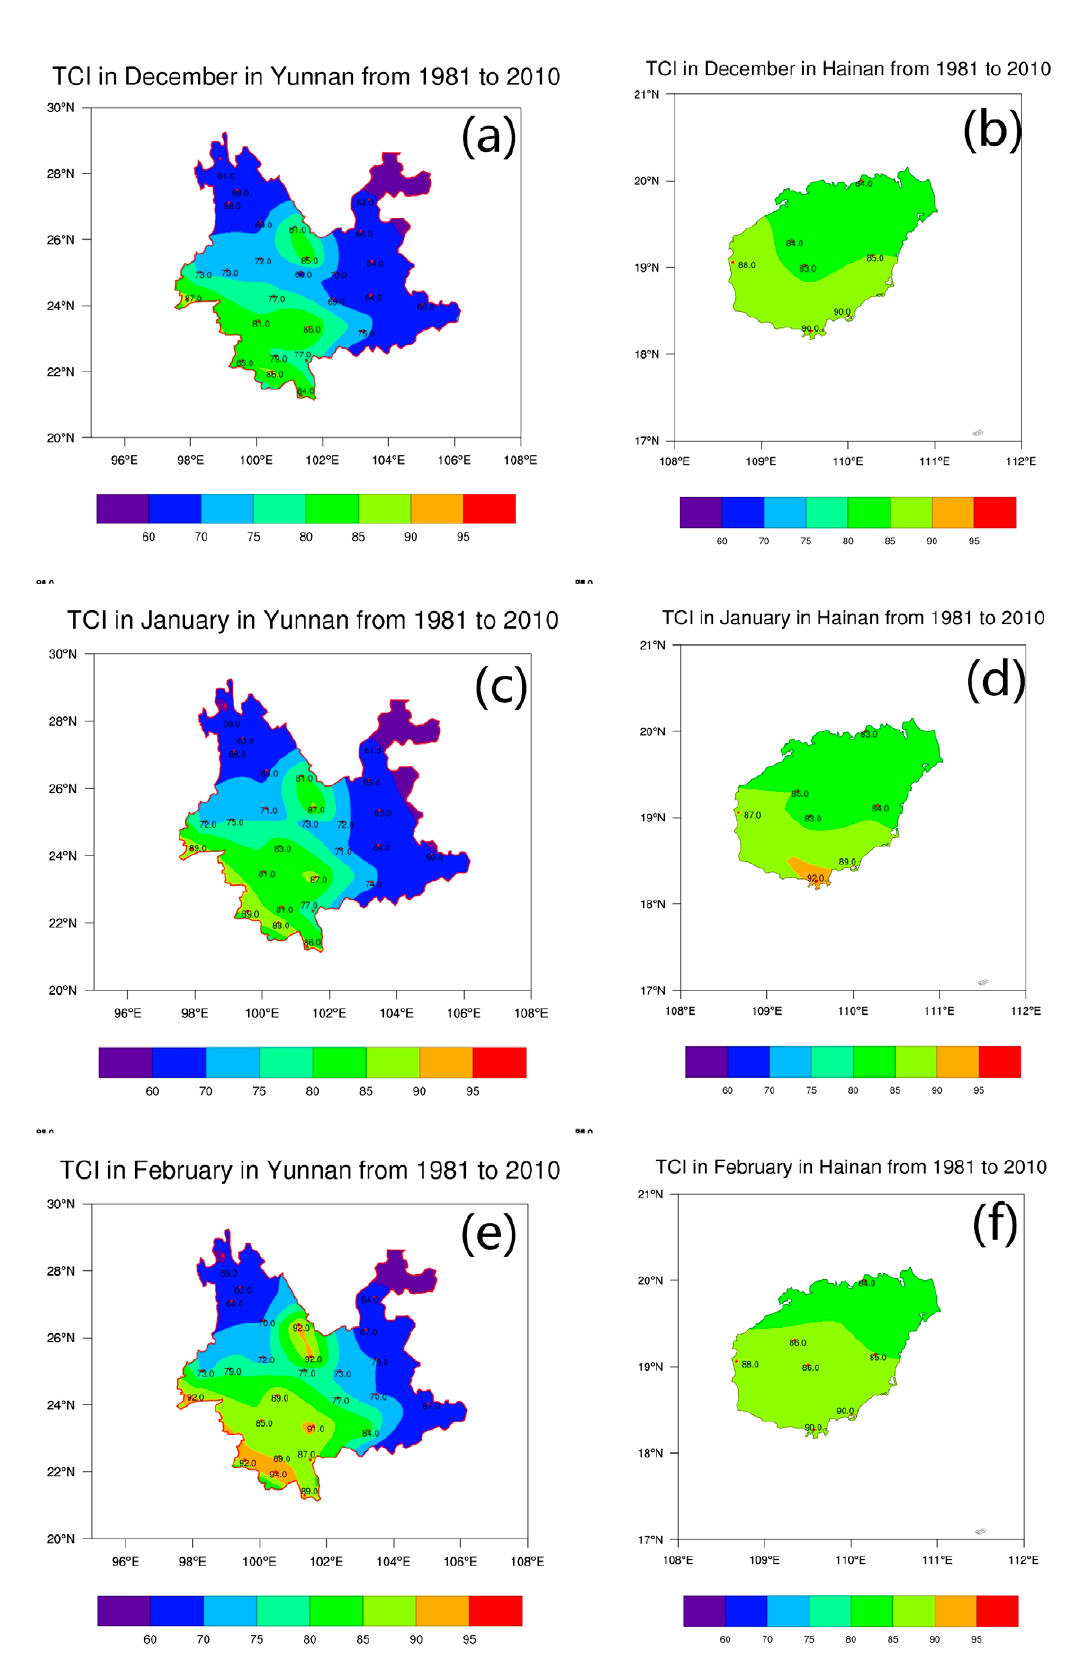
Figure 3. Mean TCI distributions for (a and b) December, (c and d) January, and (e and f) February for the period 1981– 2010. Panels (a), (c), and (e) correspond to Yunnan Province, and Hainan Province is depicted in panels (b), (d), and (f).